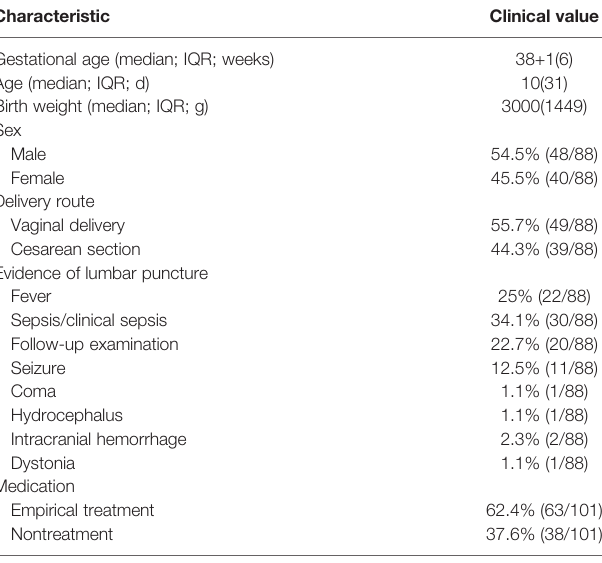
TABLE 1 | Baselines characteristics of